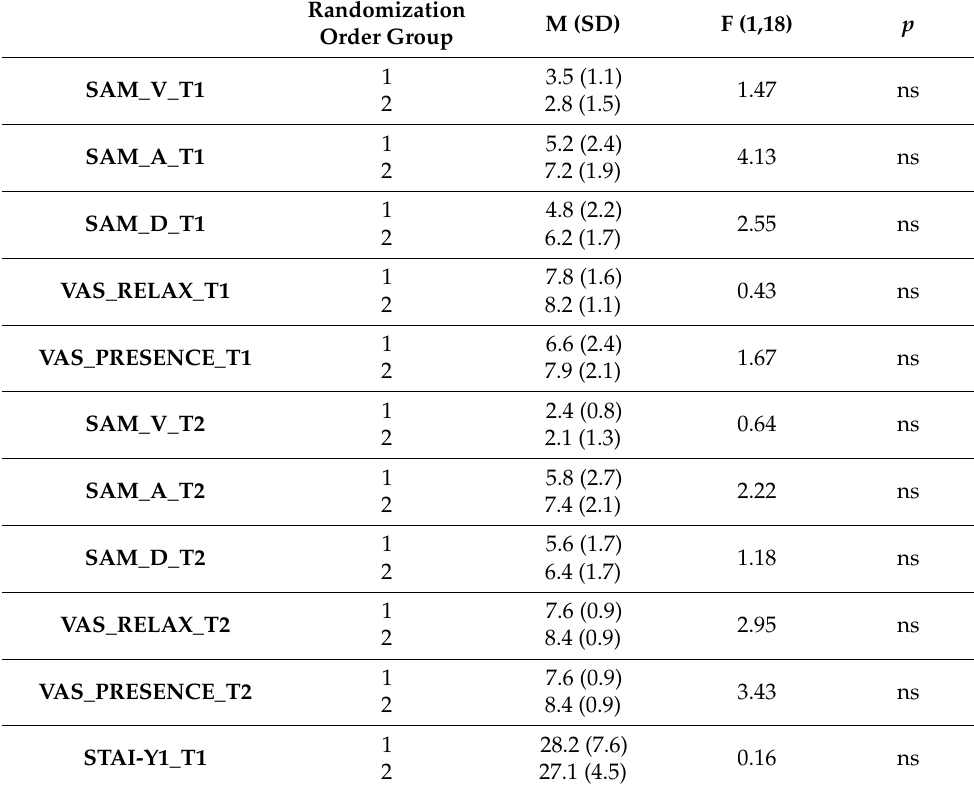
Table 2. Comparison between randomization